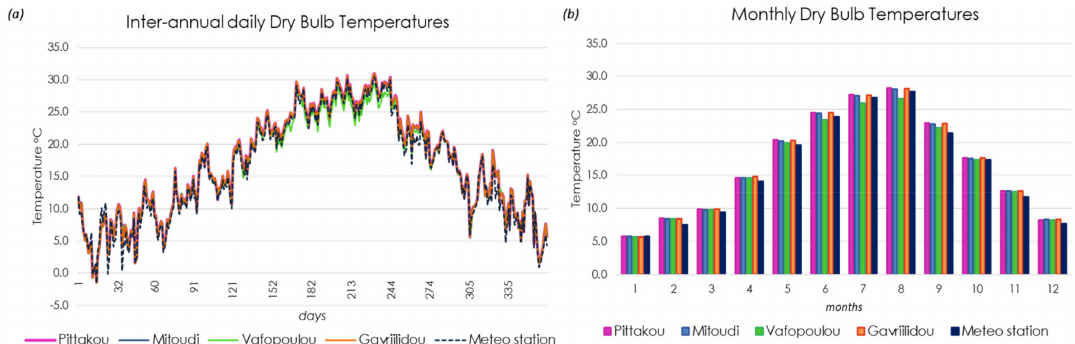
Figure 9. ( a ) Inter-annual daily dry bulb temperatures and ( b ) the mean monthly values of Tair for the urban specific weather datasets corresponding at the 3rd floor building units inside the four urban canyons and the reference weather dataset over a typical